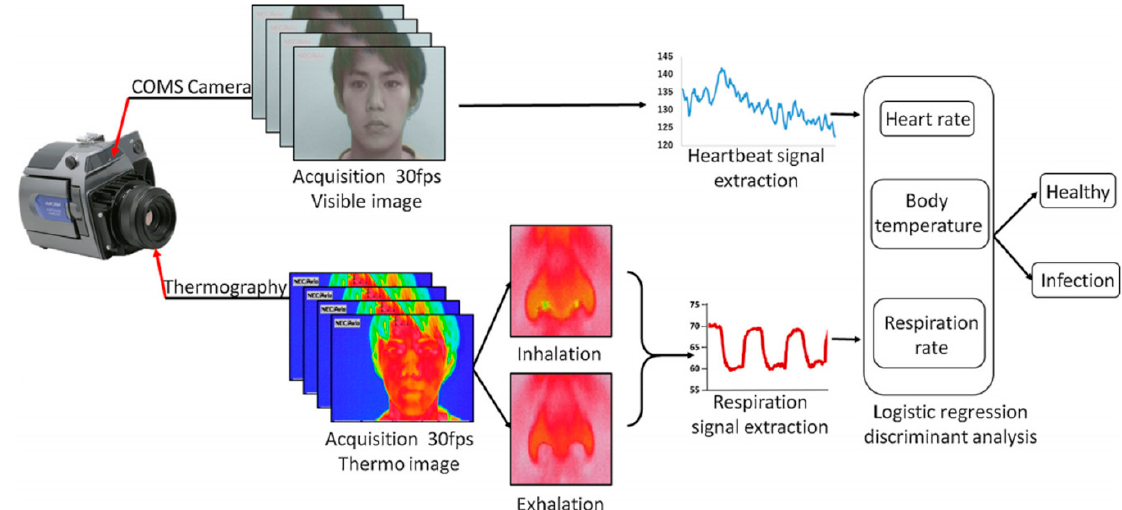
Figure 10. The visible and thermal image processing approach to sense multiple vital signs and the multiple logistic regression function remotely which helps to predict the possibility of infection [30] .